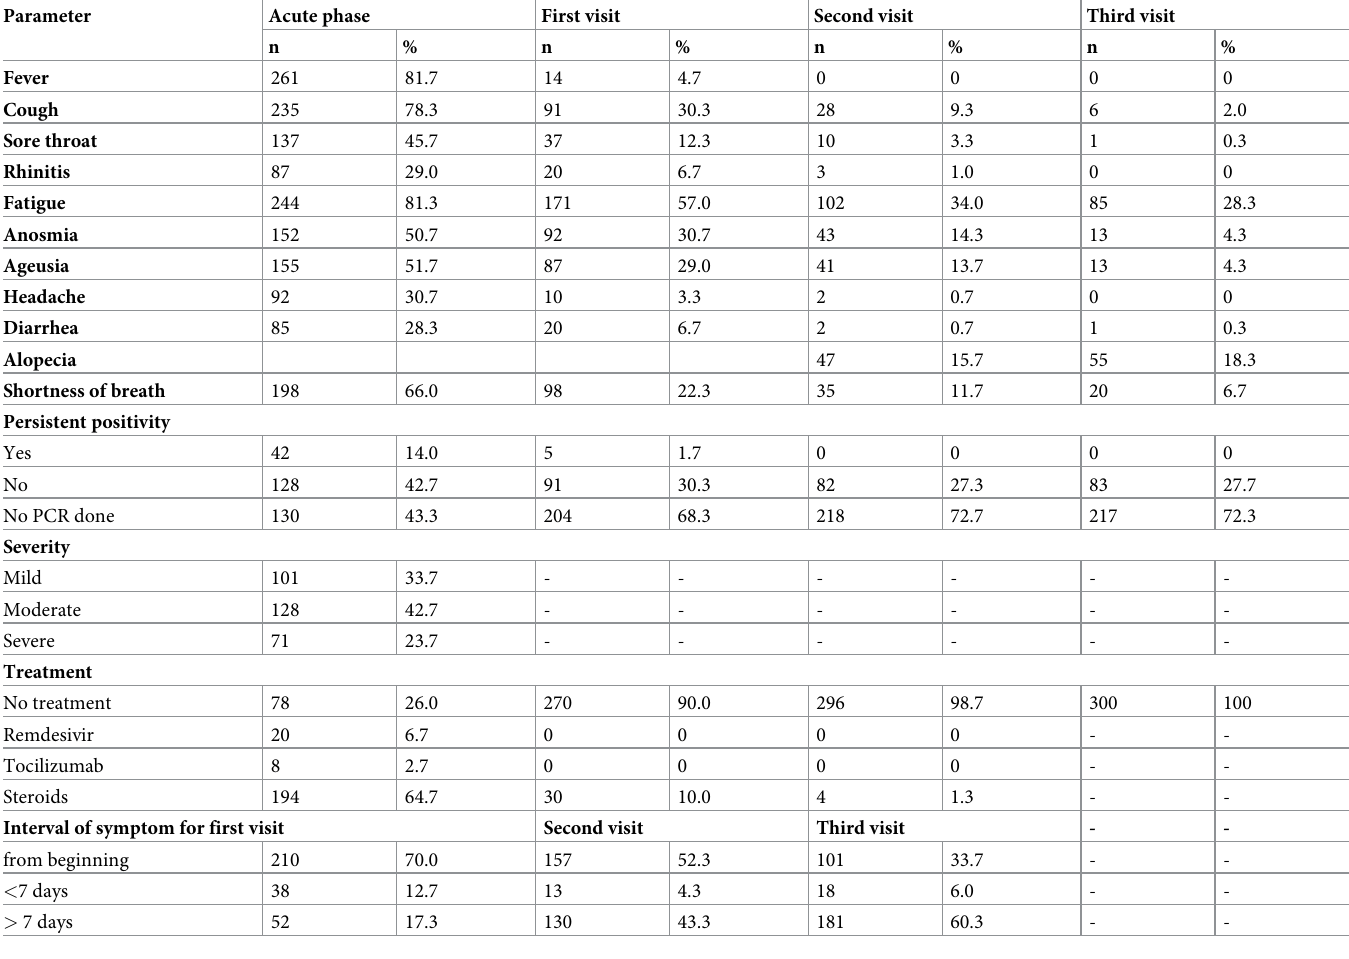
Table 2. Symptoms of patient at each